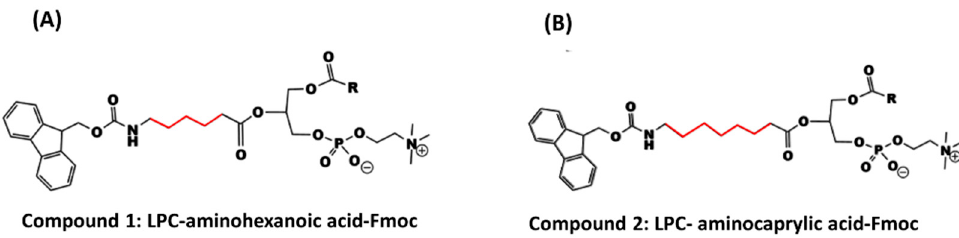
Figure 3. Structures of the newly synthesized LPC-Fmoc conjugates with increasing linker lengths 5 - CH 2 units ( A ) and 7-CH 2 units ( B ) marked in red.